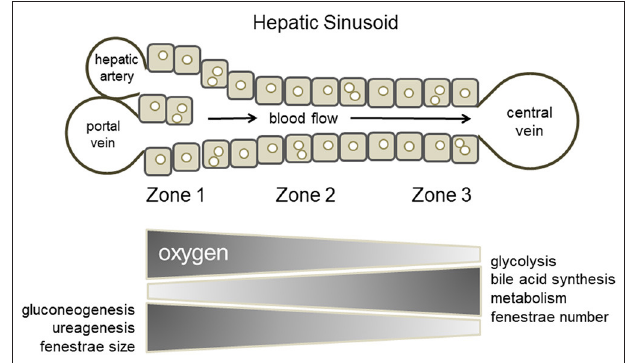
FIGURE 2 | Hepatic zonation. Hepatocytes within the lobule are divided based on differences in their functions between regions (zone 1, zone 2, and zone 3).